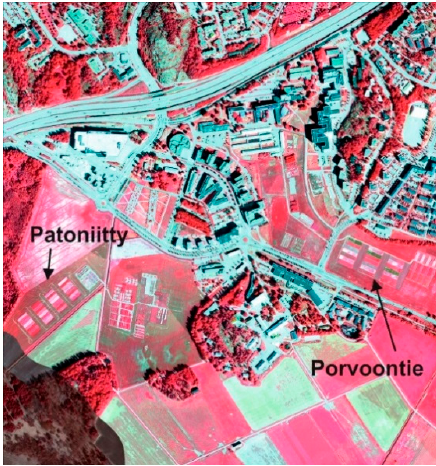
Figure 2. A false-color infrared image of the University of Helsinki Viikki campus with the experimental sites Patoniitty and Porvoontie indicated (AISA Eagle II imagery, 25 July 2011).